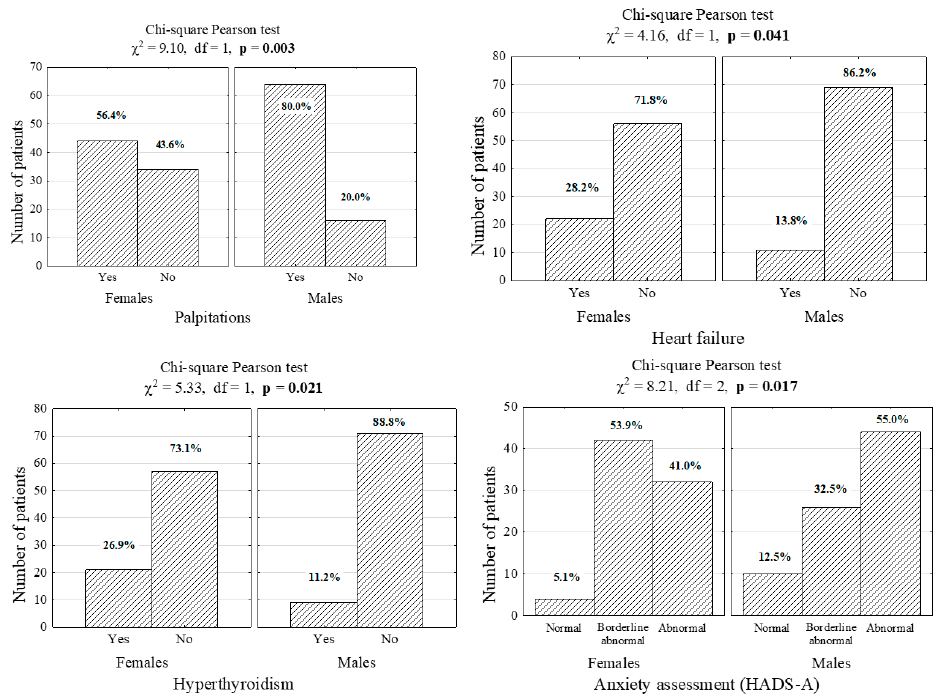
Figure 1. Number (percentage) of patients in gender and co-morbid groups ( χ 2 —independence test statistics, df—degrees of freedom, p —significance level for the test). Table 2. Basic statistics for clinical parameters characterizing the population of 158 patients with atrial fibrillation (AF).